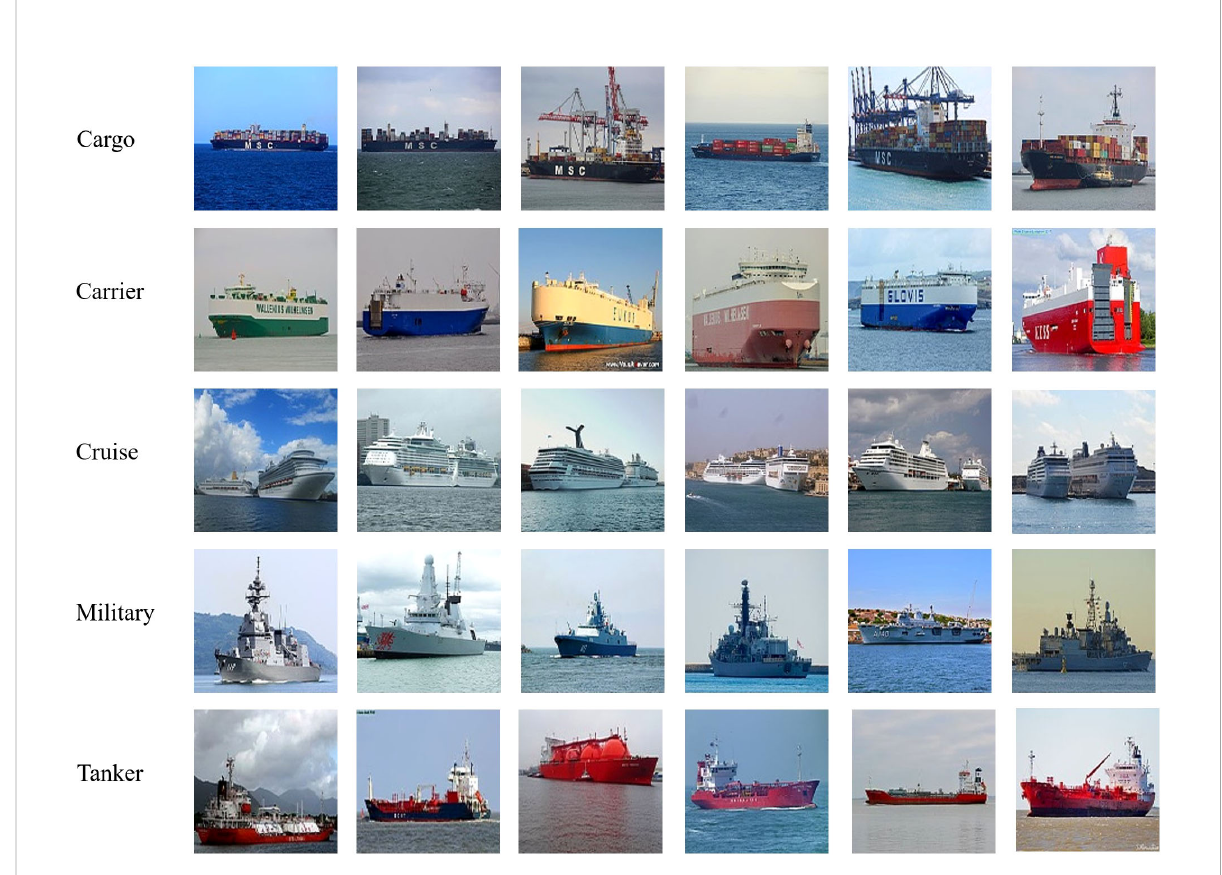
FIGURE 7 Randomly selected sample images from the